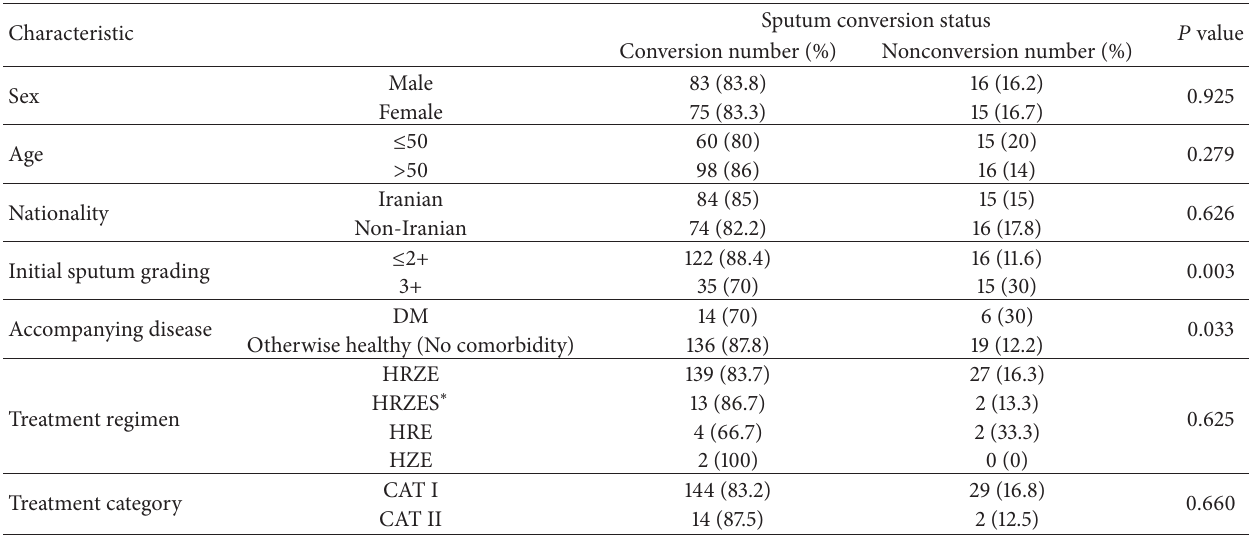
Table 2: Impact of comorbidities and demographic, microbiological, and therapeutic variables on sputum smear conversion at the end of the intensive phase ( 𝑁 = 189 ).